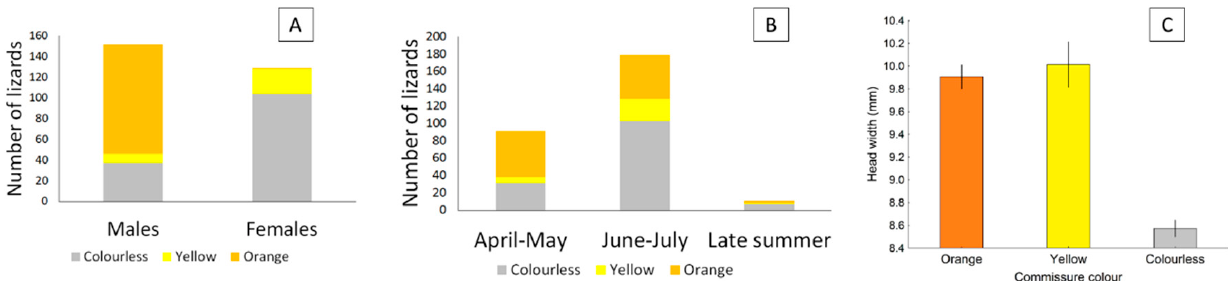
Figure 6. Frequency of P. algirus lizards with colourless, yellow or orange commissure according to sex ( A ) and season ( B ), and head width (with SE) of lizards according to commissure colour ( C ).